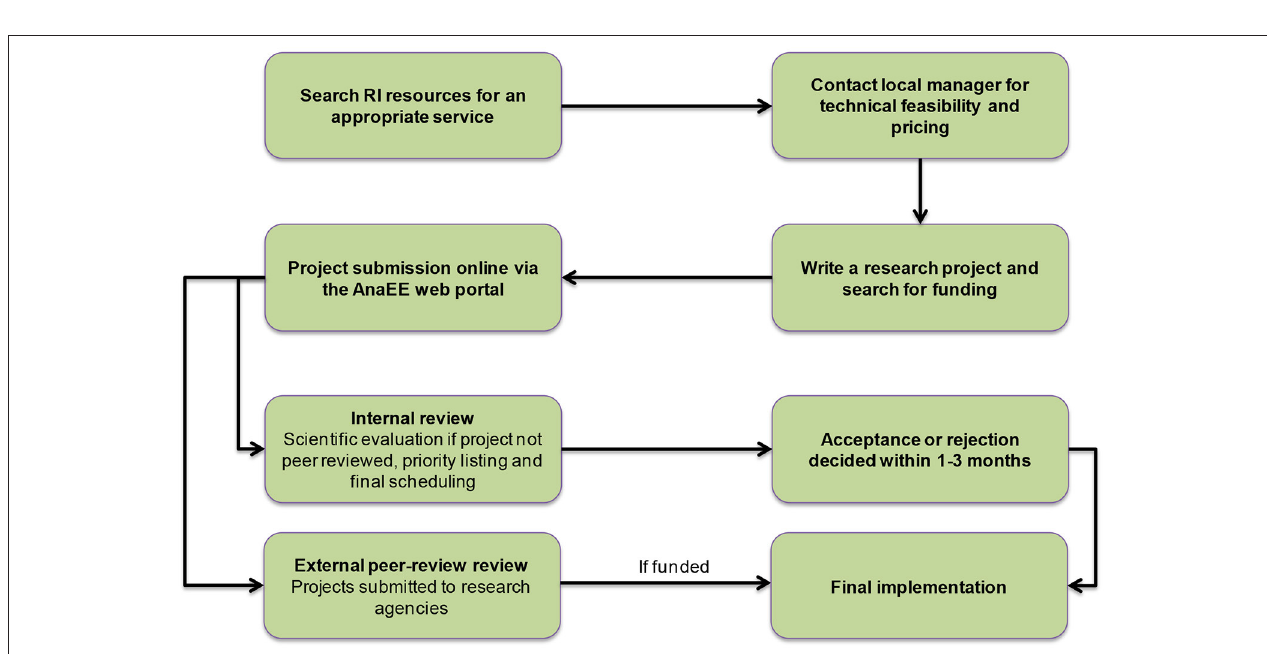
FIGURE 3 | Project submission procedure. The flow chart illustrates the standard project submission review and selection which includes either external review for funding or internal review when funding is not based on external, peer-review.